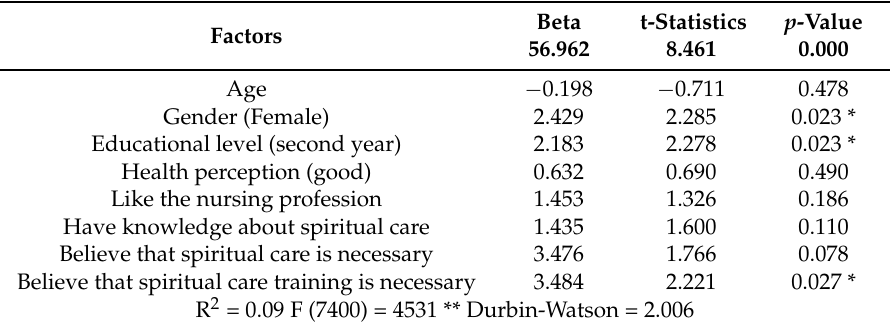
Table 5. Regression model predicting nursing students’ perceptions of spirituality and spiritual care ( n =